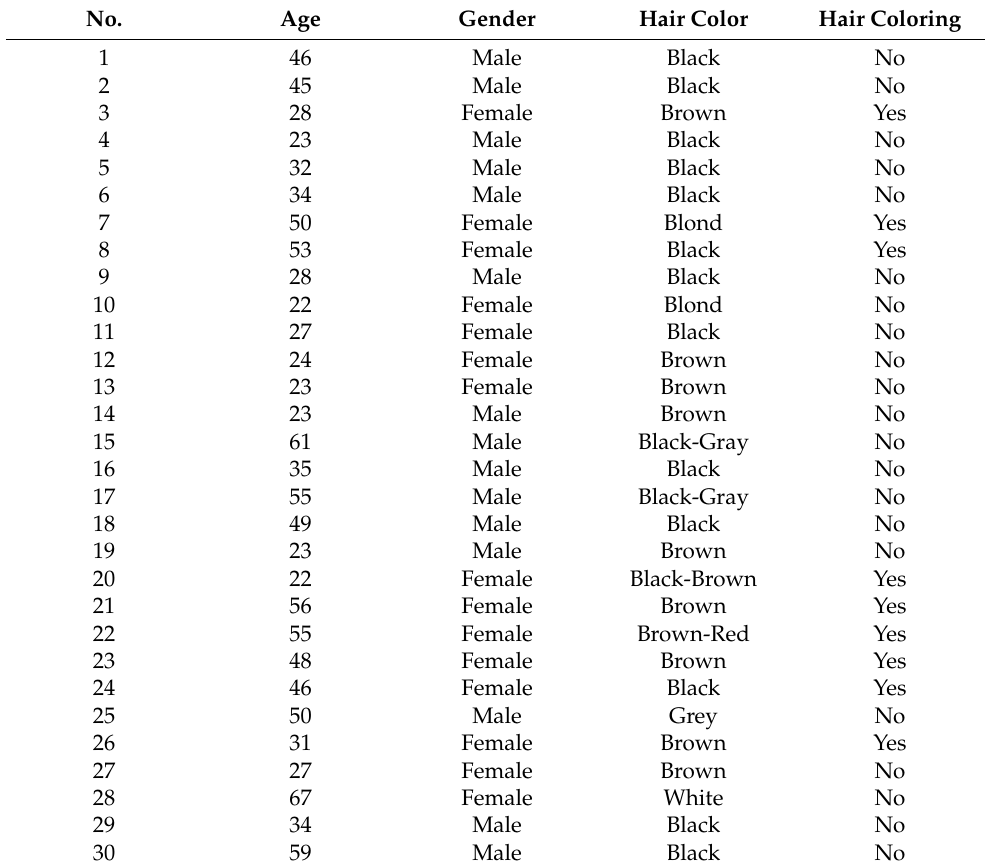
Table 1. Data of volunteers included in the